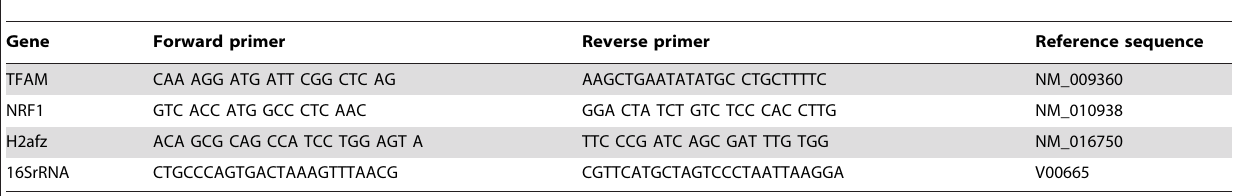
Table 3. Genes investigated and relevant primer sequences.